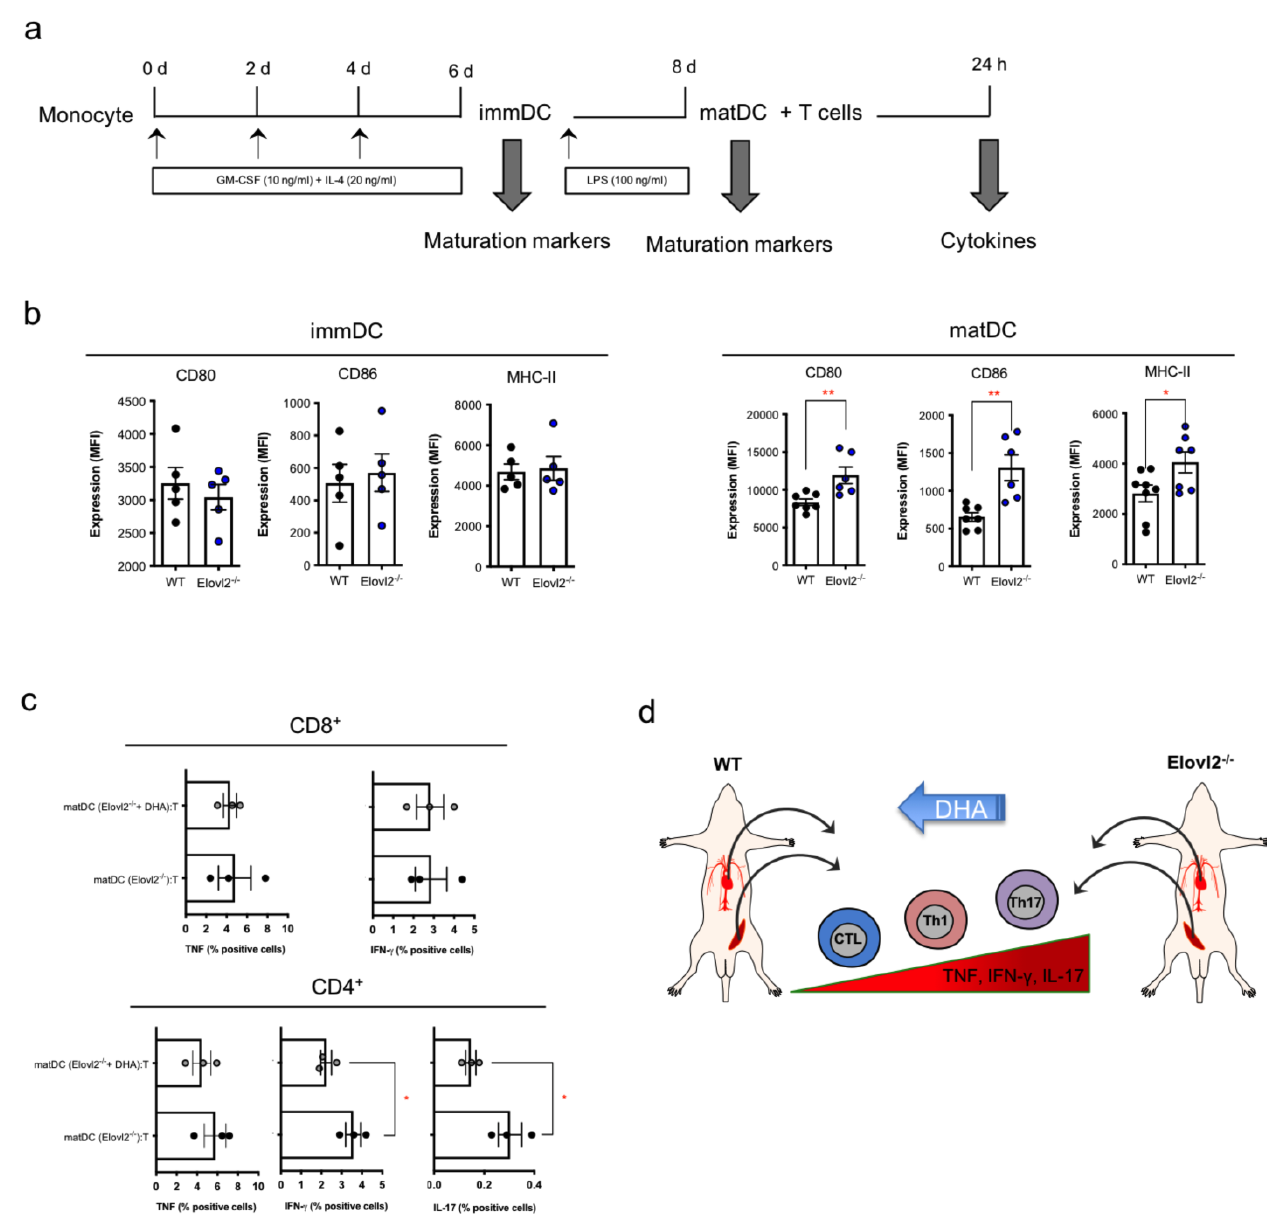
Figure 4. ( a ) Schematic representation of the experimental design; ( b ) histograms of surface expres- sion of CD80, CD86, and MHC-II in immDC and matDC of WT, Elov2 − / − , and Elov2 − / − + DHA. ( c ) histograms of intracellular TNF- α and IFN- γ production from CD8+ and IFN- γ and IL-17 produc- tion from CD4+ following co-culture with matDC obtained from Elov2 − / − and Elov2 − / − + DHA. ( d ) Summary of DHA-induced influence on T-cell subsets. * p < 0.05; ** p <